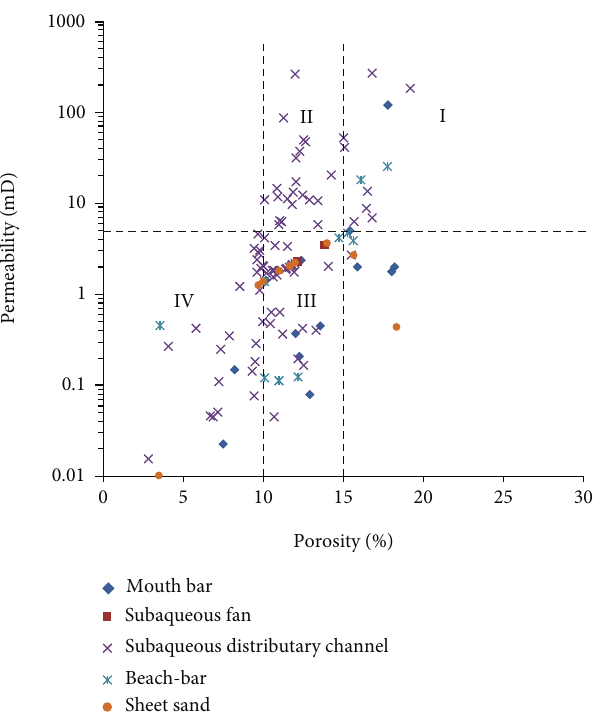
Figure 10: The plot of porosity versus permeability for di ff erent depositional facies. I: medium porosity and low permeability; II: low porosity and low permeability; III: low porosity and ultra-low permeability; IV: ultra-low porosity and ultra-low